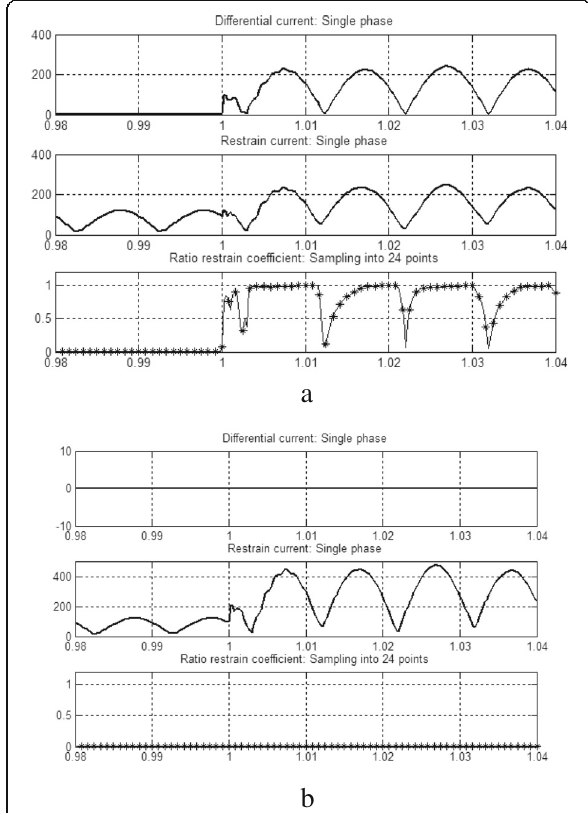
Fig. 11 The differential current, restrain current and ratio restrain coefficient of the EBDP III. a The wide differential current of Bus III. b The differential current of Bus III